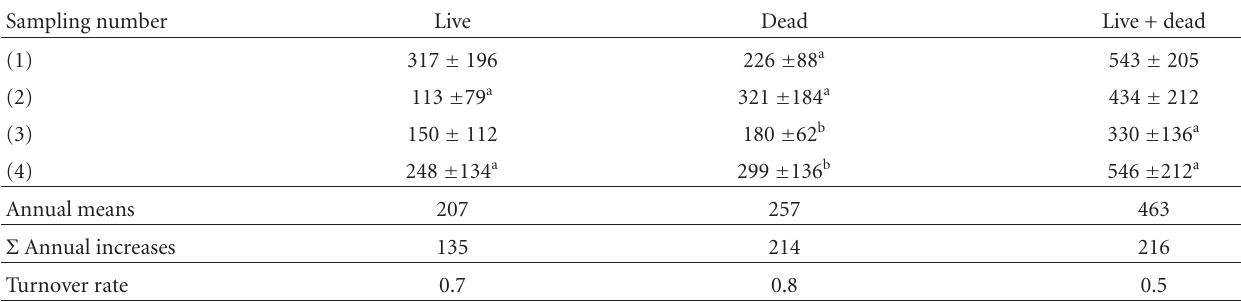
Table 3: The amount of live, dead, and live + dead fine roots ( < 1mm in diameter) and di ff erences on di ff erent sampling occasions, annual means, Σ annual increases of fine roots and turnover rate of live, dead, and live + dead fine roots at a fresh/moist coniferous fern forest site at